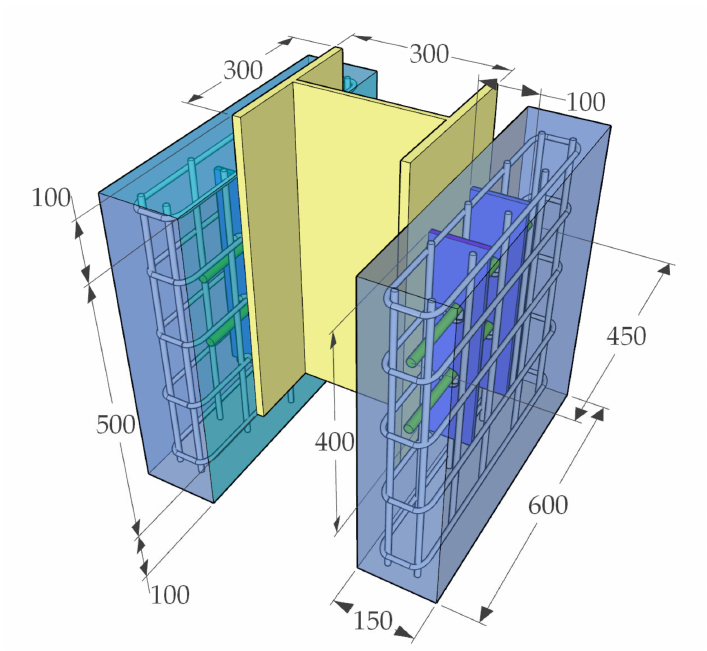
Figure 1. Dimensions and details of specimens (unit: